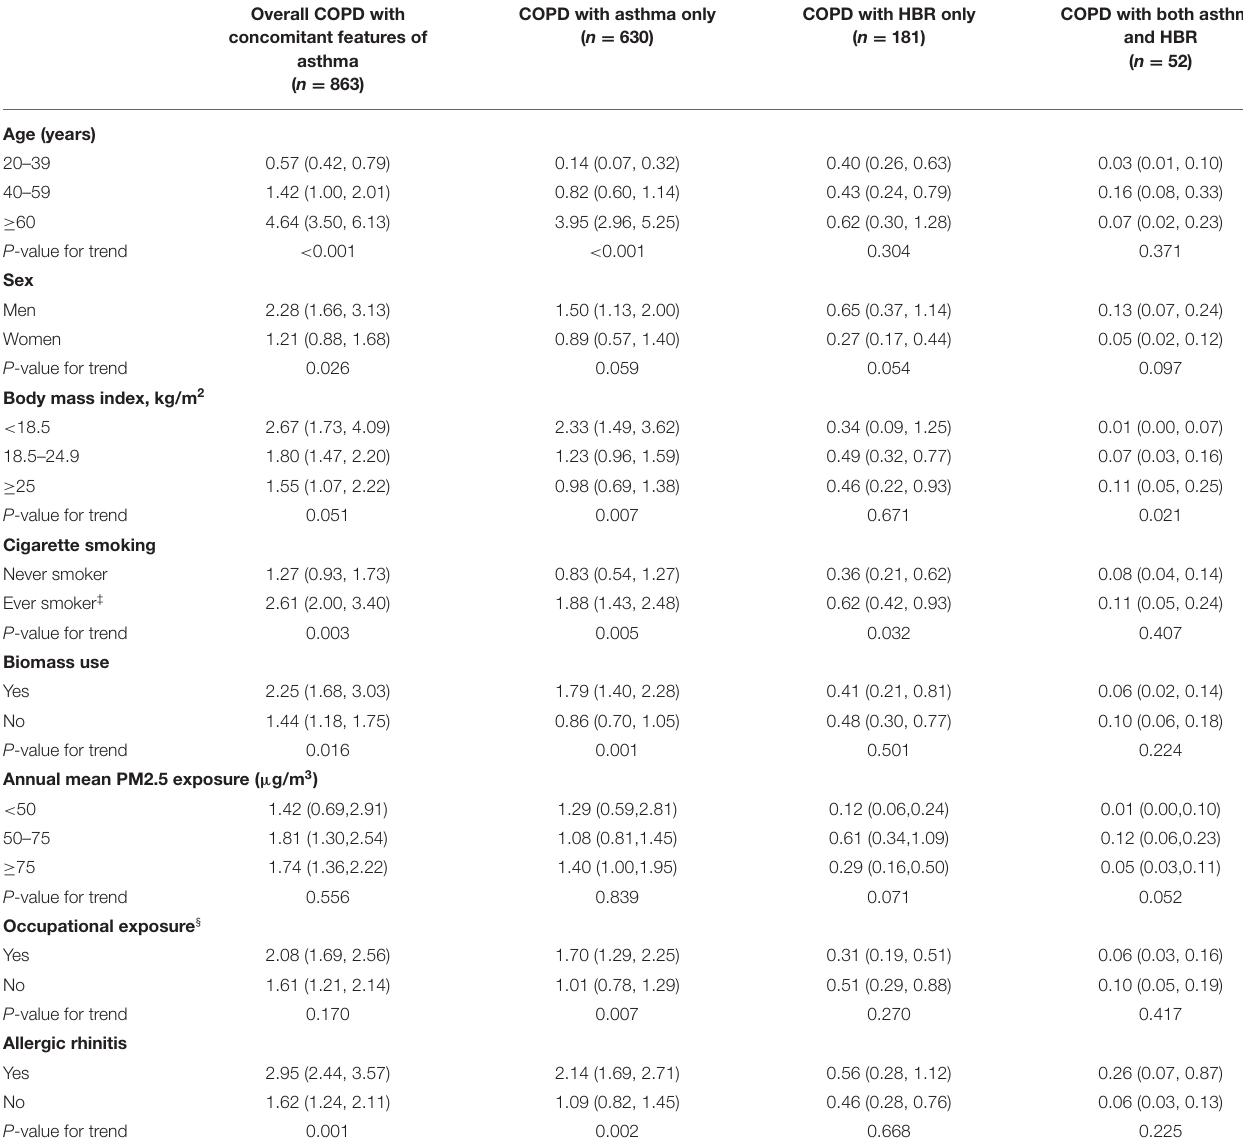
TABLE 2 | Age-specific and age-standardized prevalence of COPD with concomitant features of asthma in the general adult population.